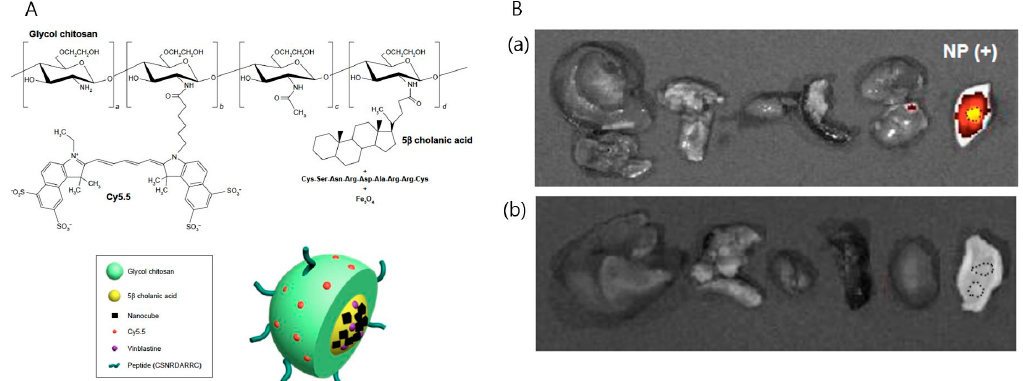
Figure 6. ( A ) Chemical structures and schematic diagram of glycol chitosan conjugated to hydrophobic 5 β -cholanic acid and bladder cancer-targeting peptide (CSNRDARRC) and physically loaded with iron oxide nanocubes (NCs); ( B ) the combination demonstrated a specific tumor-targeting capability with minimized accumulation in other organs: ( a ) after NP administration and ( b ) before NP administration (Adapted with permission from [9]. Copyright 2016 DOVE Medical Press).